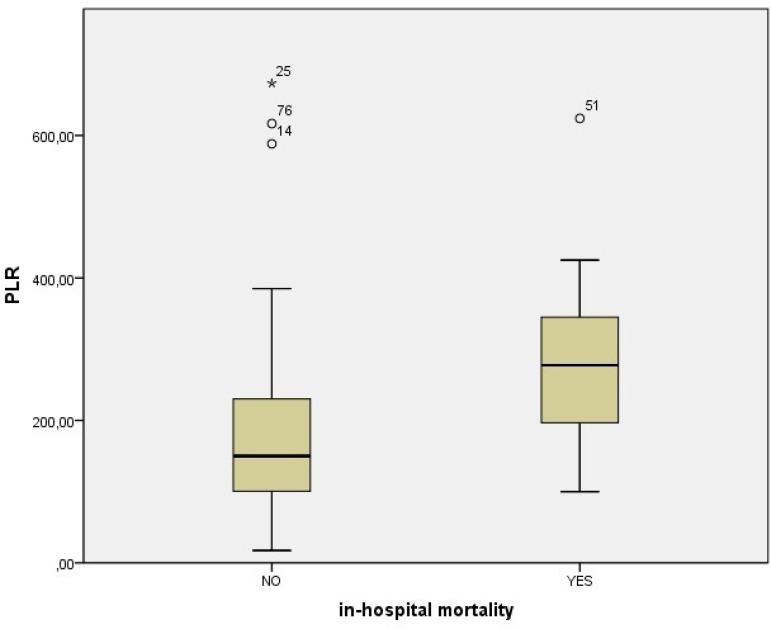
Comparison of platelet to lymphocyte ratio (PLR) between survivor and non-survivor patients admitted with type A acute aortic dissection.